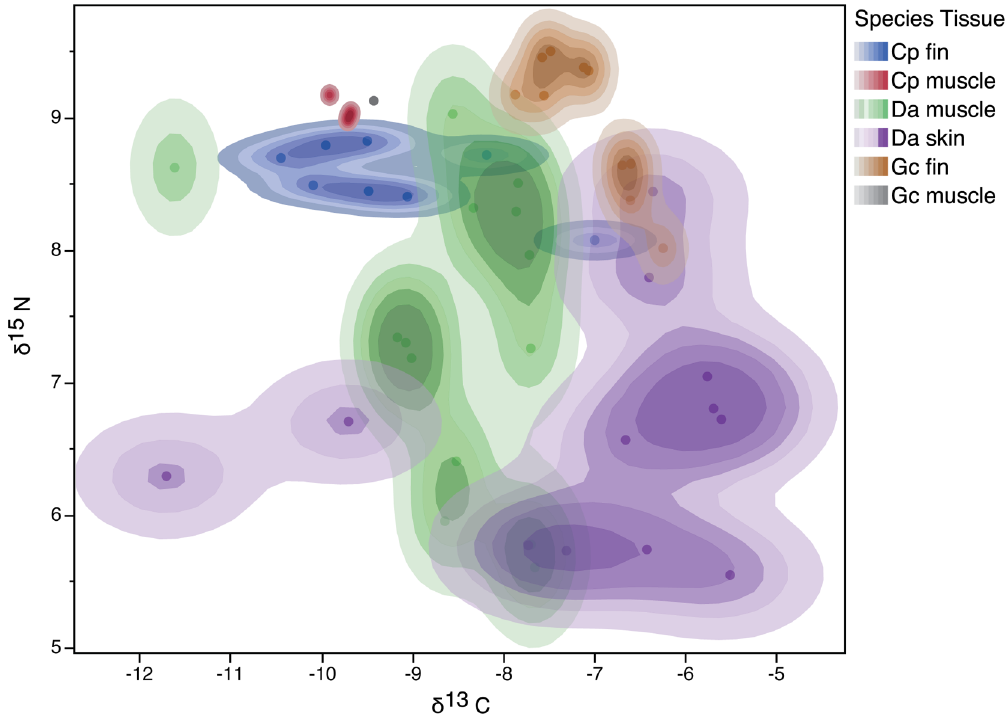
Figure 2. Density contour plot of d 13 C vs. d 15 N values for C.perezifin(blue)andmuscletissues (red), G.cirratum fin (brown) and muscle (grey) and D.americana skin (purple) and muscle (green) sampled from wild populations at Glovers Reef Atoll, Belize. Different colour tones represent quartile volume contours constructed using kernel density estimation.